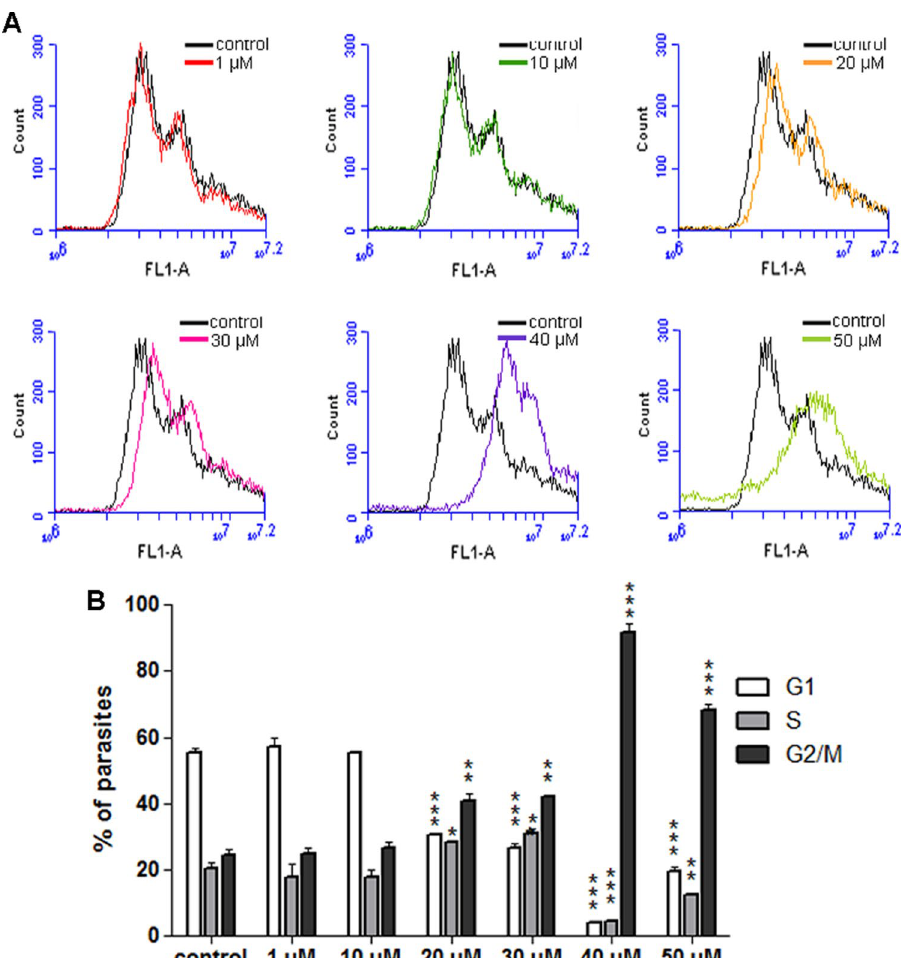
Figure 11. Epimastigotes cell cycle after removal of FEX from the medium. ( A ) Histograms of control and treated parasites. Black and color lines indicate untreated and previously treated epimastigotes, respectively. ( B ) Percentage of parasites in G1, S, and G2/M. The main difference occurred after treatment with 40 and 50 µM when there was a great change in the percentage of parasites in the G1 and G2/M phases. The histograms are representative and the data are the average of two independent experiments (*p > 0.05; **p < 0.05; ***p < 0.001).